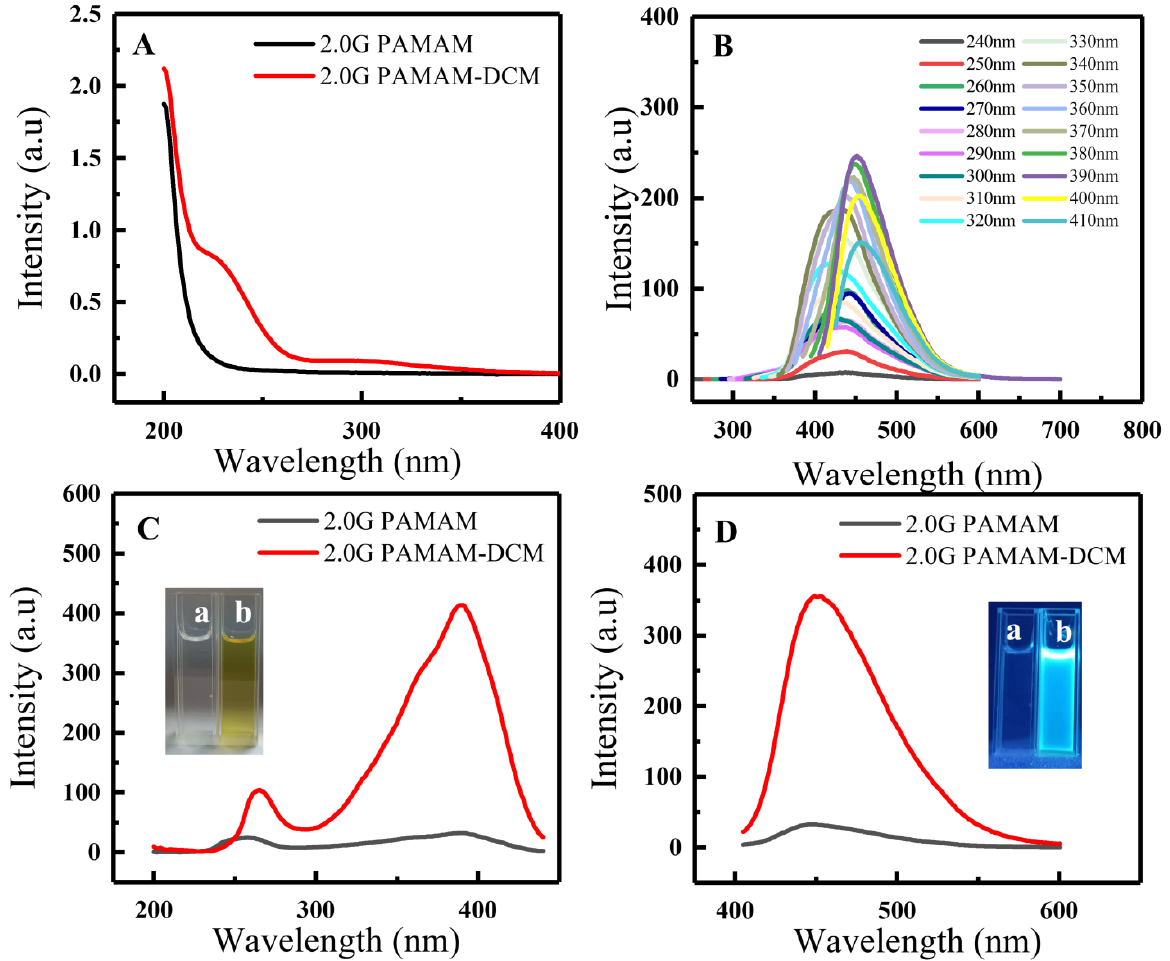
Figure 2. ( A ) UV–Vis spectra; ( B ) fluorescence emission spectra of 2.0G PAMAM-DCM PDs under different excitation wavelengths, ( C ) excitation spectra ( λ EM = 450 nm), and ( D ) emission spectra of 2.0G PAMAM and the 2.0G PAMAM-DCM PDs ( λ EX = 390 nm). (a) 2.0G PAMAM, (b) 2.0G PAMAM-DCM. In the insets of ( B , C ) are photographs taken under sunlight and UV light ( λ EX = 365 nm), respectively.